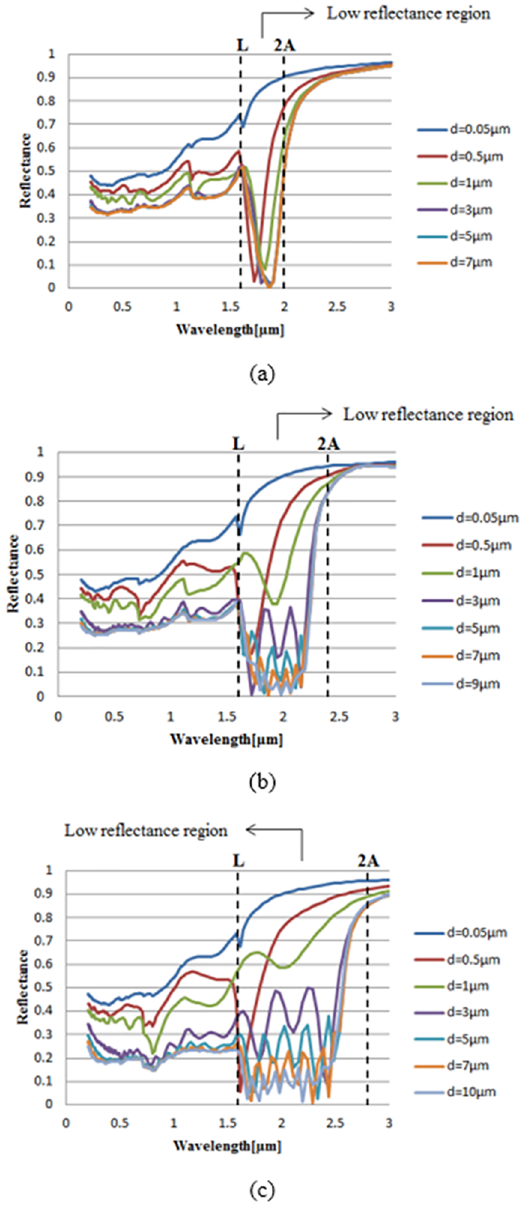
Figure 3. Reflectance spectrum for different depths of circular pattern in PhC with a period L=1.6µm and aperture A= (a) 1µm (b) 1.2µm (c) 1.4µm. In order to show the influence of period of photonic structure on the reflectance spectrum, nano structures with different periods (1.25~5 µm) was simulated with the aperture defined in two cases as A = 1 µm and A = L-0.6 µm respectively. The depth of the structure remains equaling to the period. Fig. 4 shows the resulting reflectance spectra of the PhCs together with the case of flat tungsten. Notice that all the spectra have a low reflectance trough at the wavelength close to period (indicated in black dash line). The result indicates that the period of the PhC structure primarily determines the region of low reflectance in the spectrum.